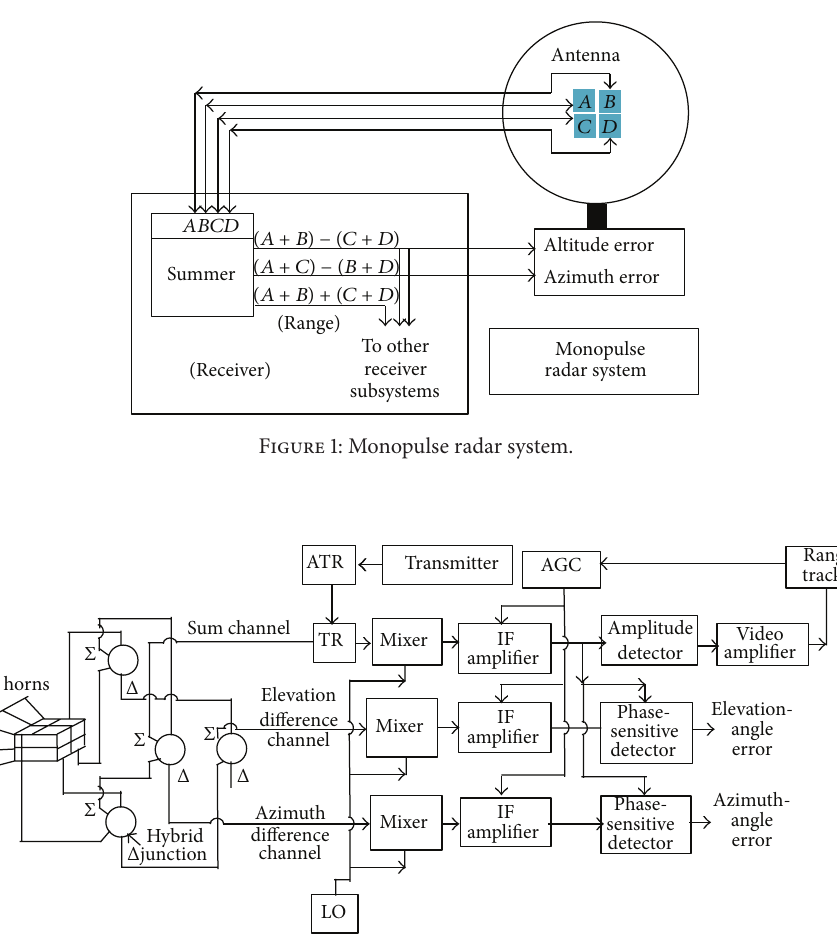
Figure 2: A tracking radar